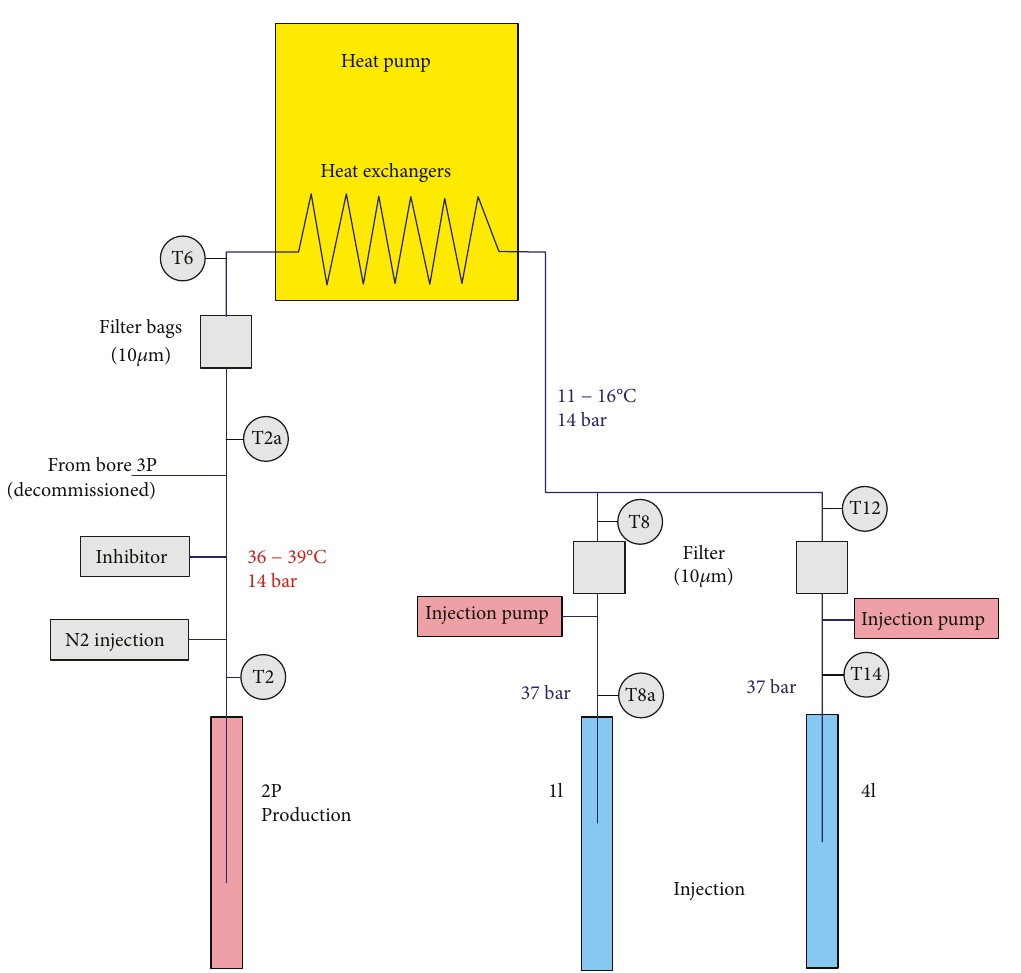
Figure 8: Schematic of KGDP, showing locations of sampling (T2, T2a,